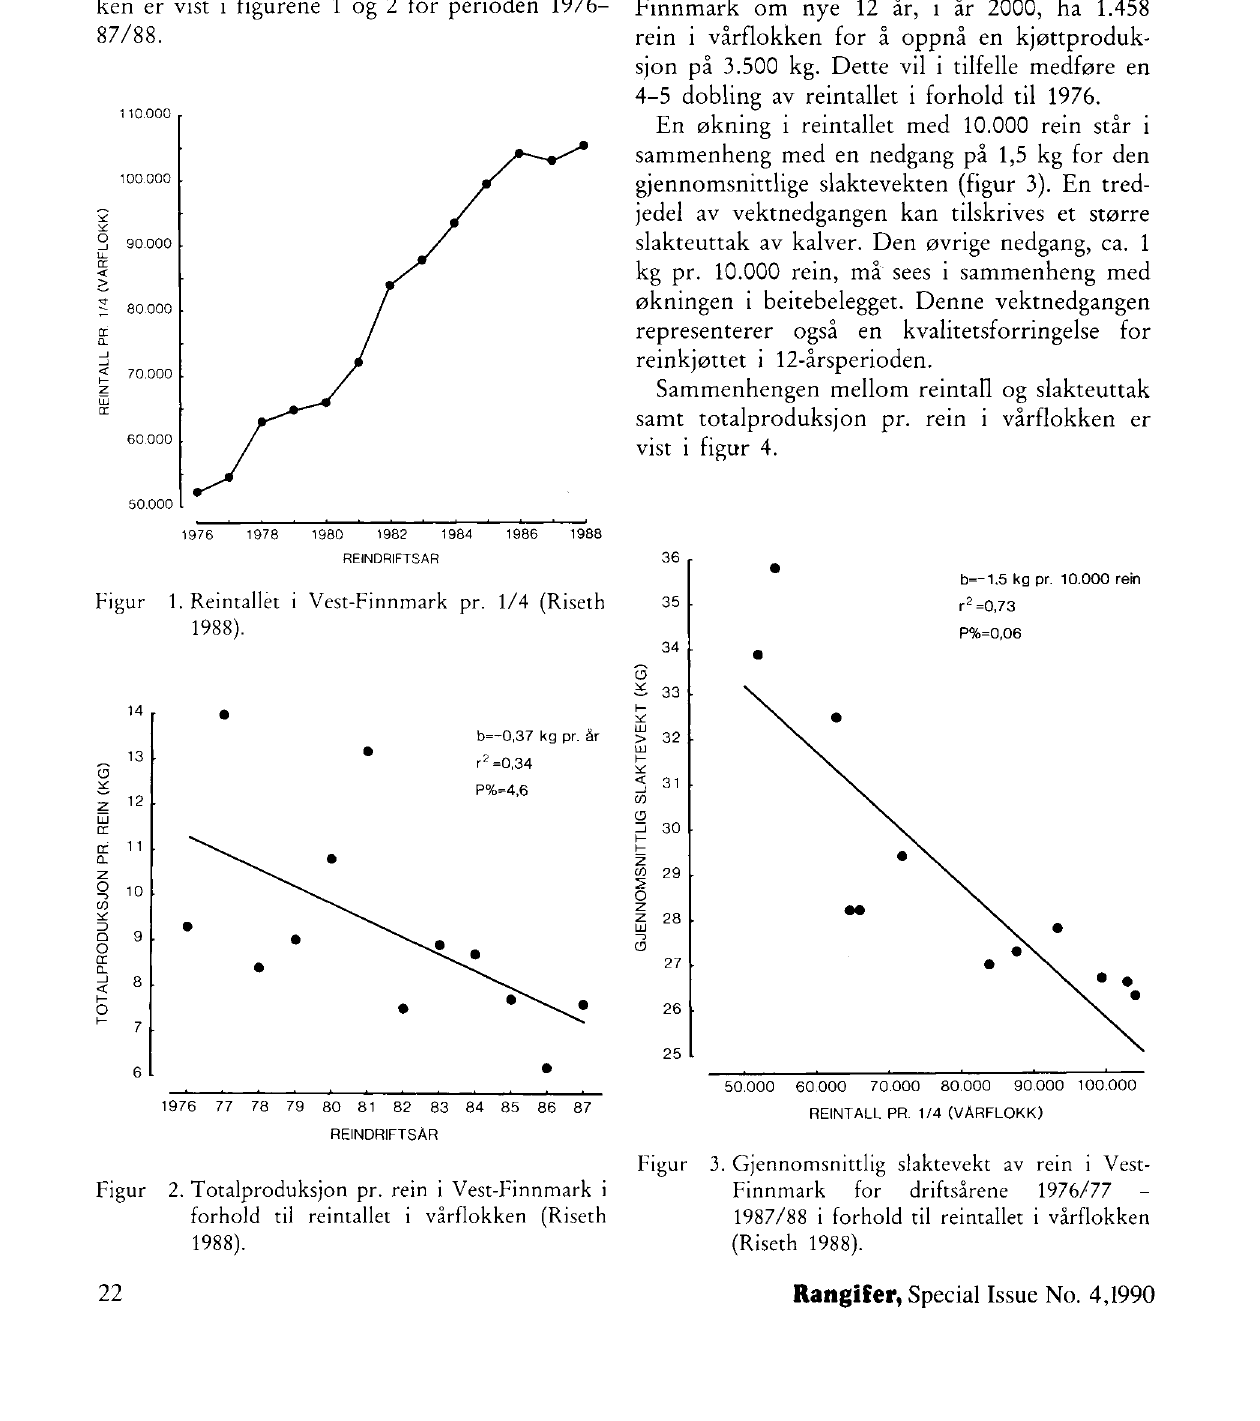
(figur 2). Mens det eksempelvis ble produsert